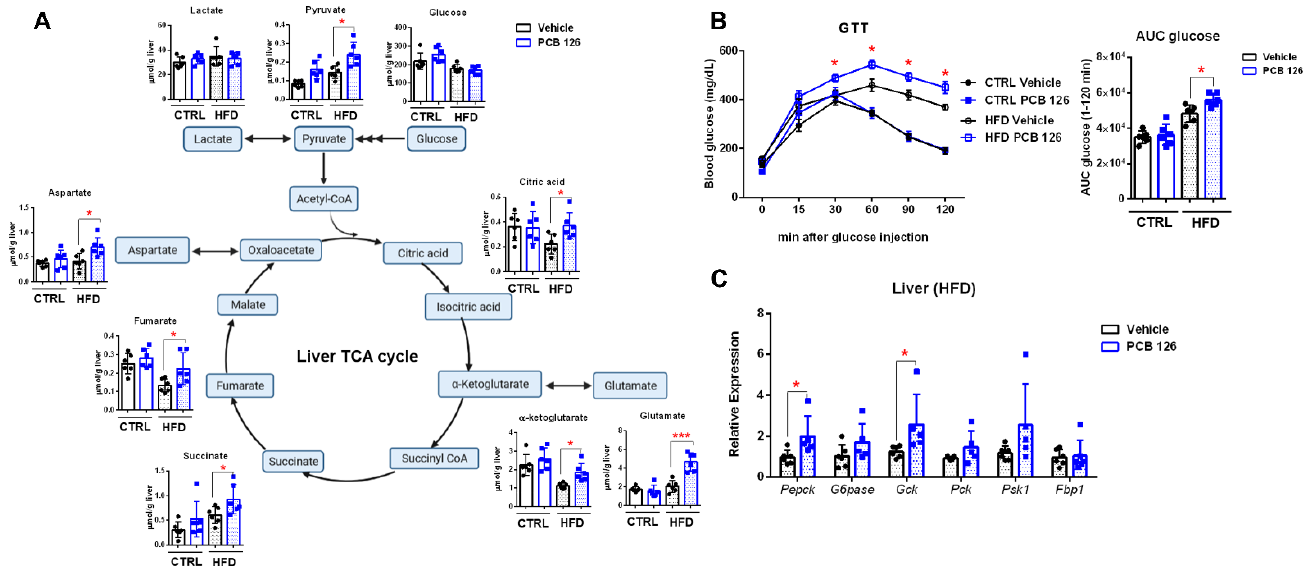
Figure 4. Effects of early life PCB 126 on glucose metabolism in mice with CTRL or HFD. ( A ) Quantitative 1 H NMR analysis of metabolites involved in tricarboxylic acid (TCA) cycle flux in liver from CTRL or HFD-fed mice with vehicle or PCB 126 exposure. ( B ) Blood glucose levels following injection of glucose and the area under the curve (AUC) from CTRL or HFD-fed mice with vehicle or PCB 126 exposure. ( C ) qPCR analysis of mRNA encoding gluconeogenesis in liver from HFD-fed mice with vehicle or PCB 126 exposure. Values are means ± S.D. (n = 6 per group). * p < 0.05, *** p < 0.001 compared to vehicle.